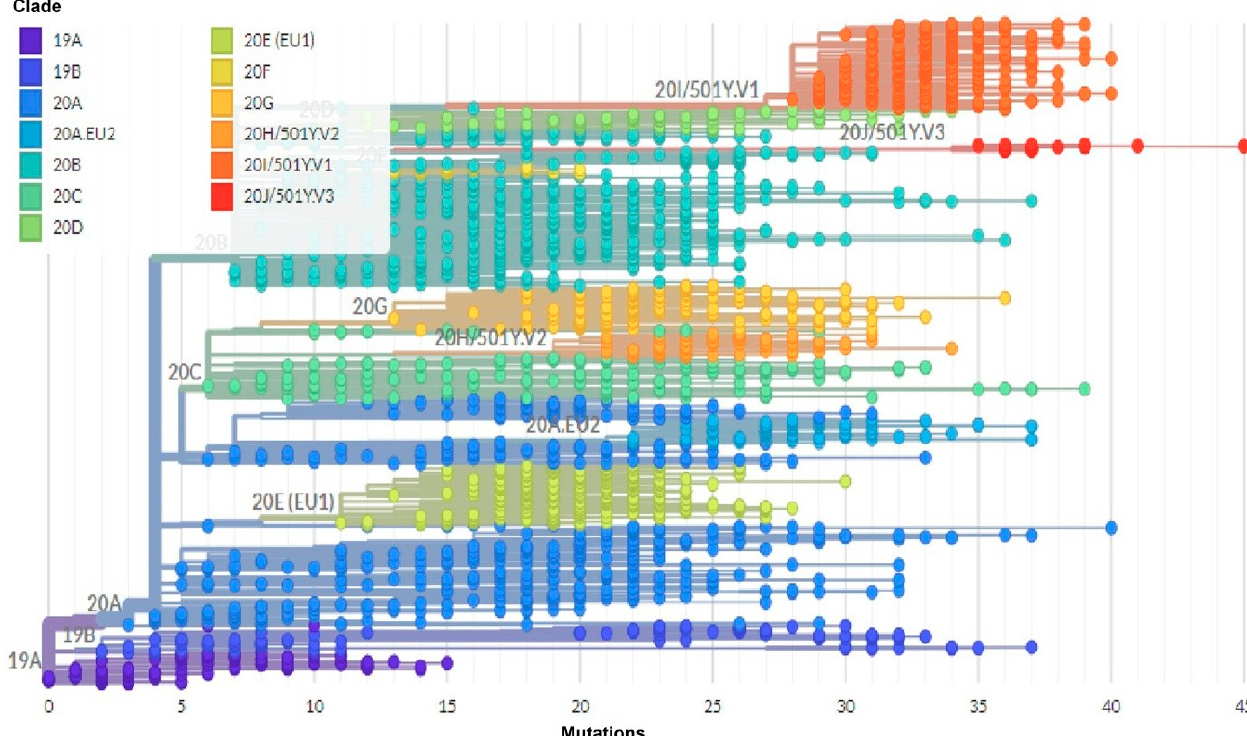
Figure 6. Phylogenetic analysis of SARS-CoV-2 isolates from different continents. SARS-CoV-2 clades were present in different continents.